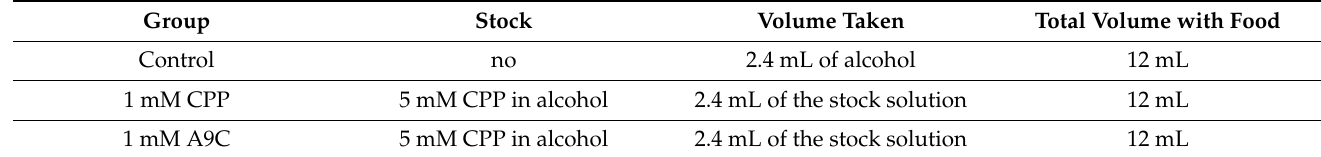
Table 5. Flies feeding pattern for the chloride channel blockers groups and